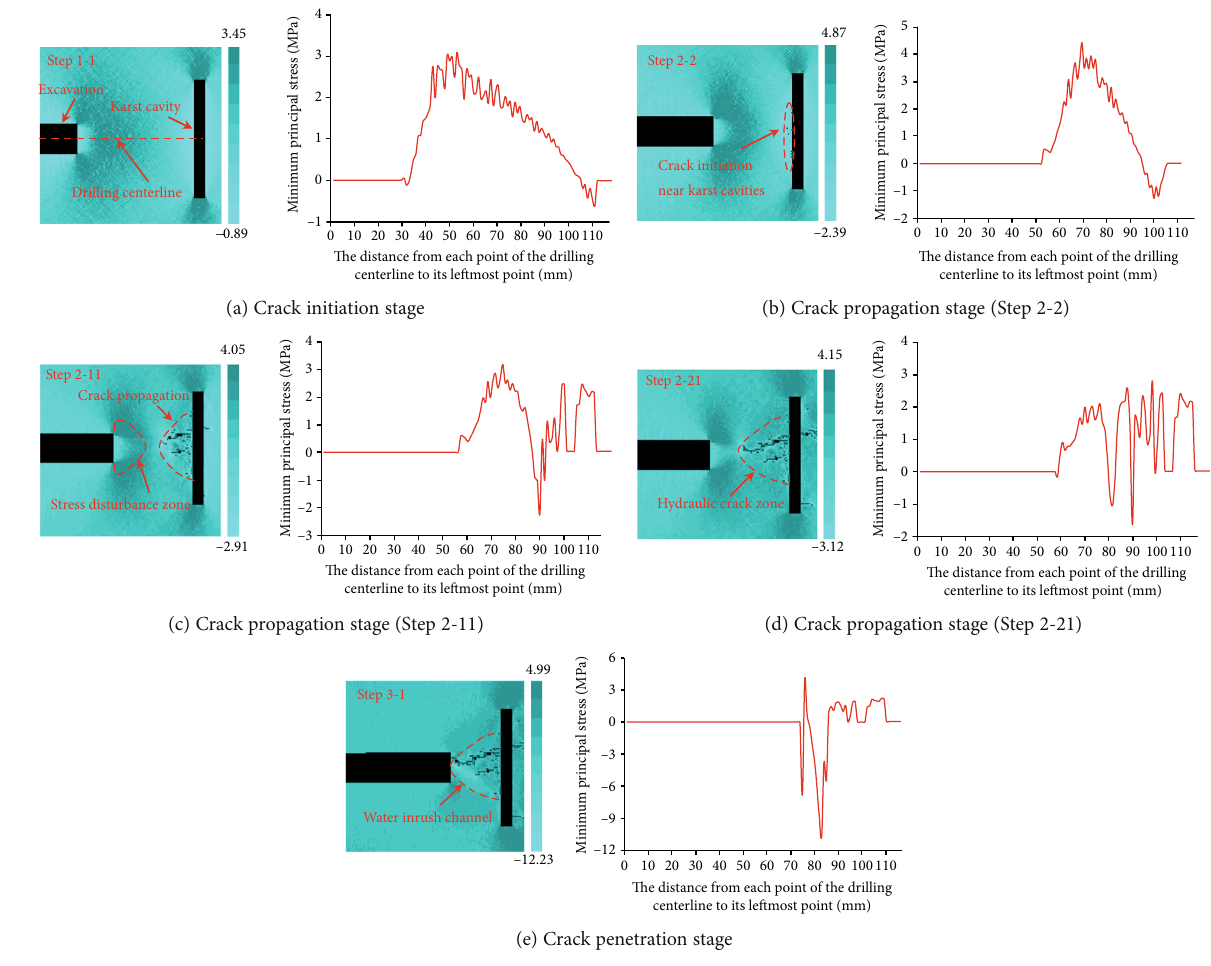
Figure 6: The minimum principal stress